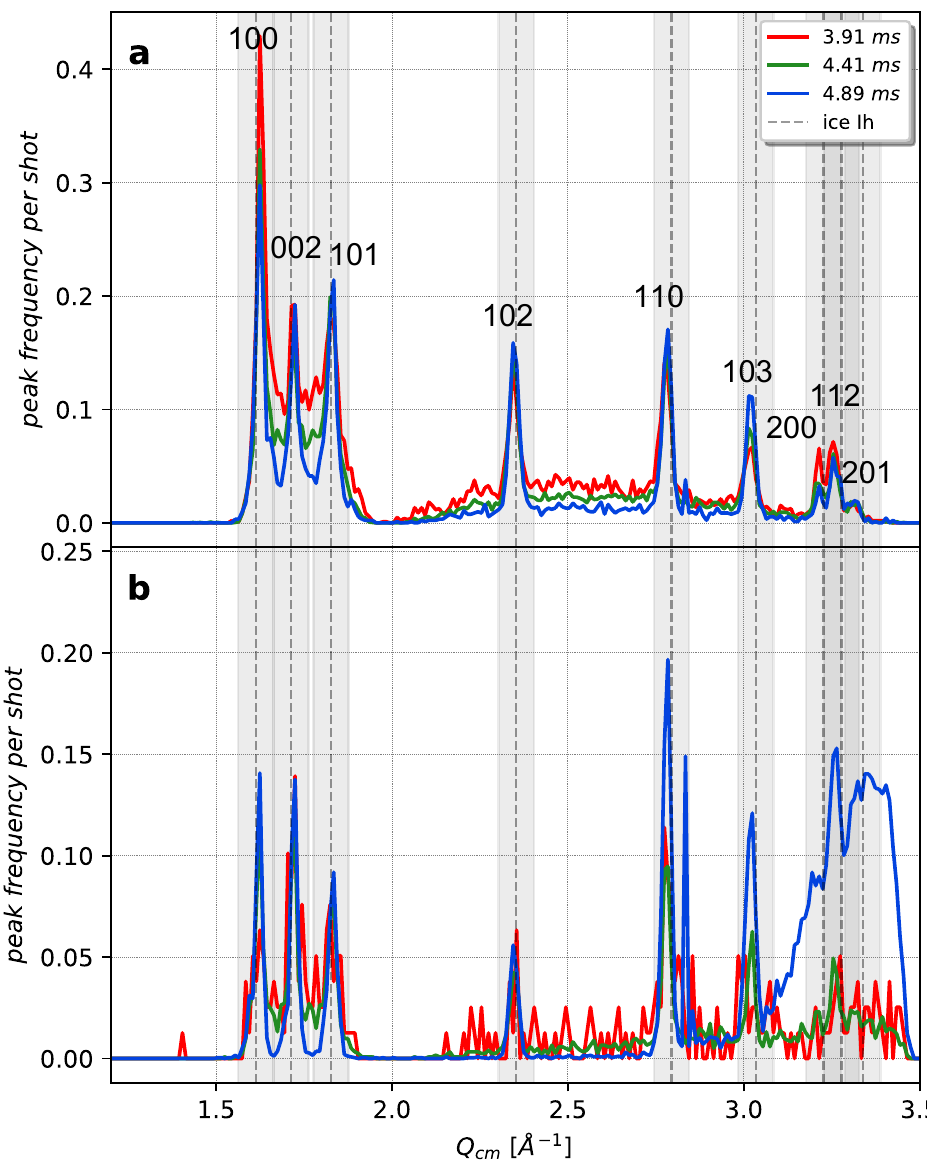
Figure 3. Frequency of a peak appearing at a certain momentum transfer in a shot as a function of its center of mass in reciprocal space ( Q cm ) for the hits ( a ) above 50 ADU/pixel and ( b ) below 50